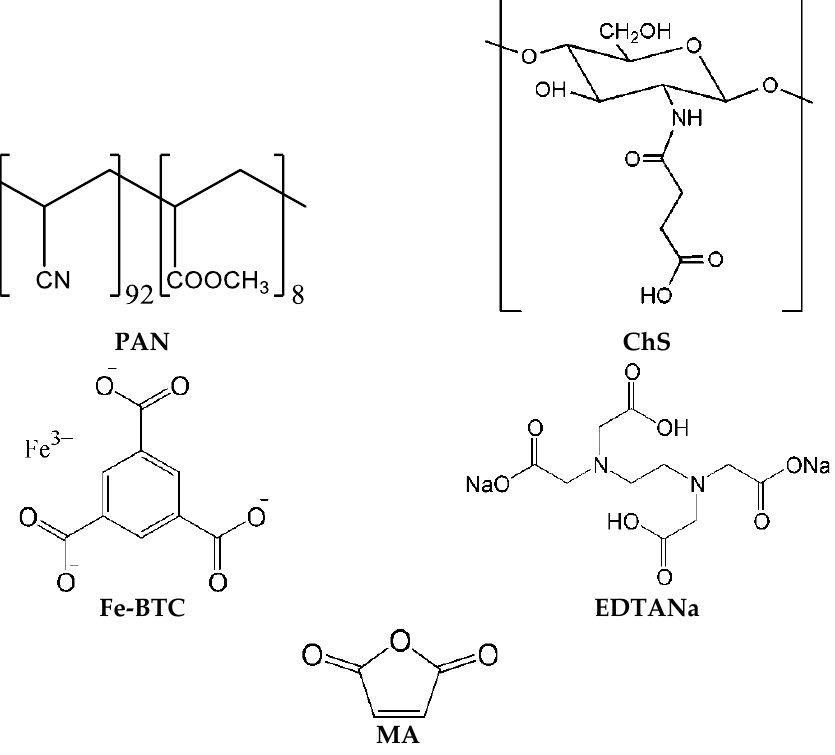
Figure 1. Structural formulas of used